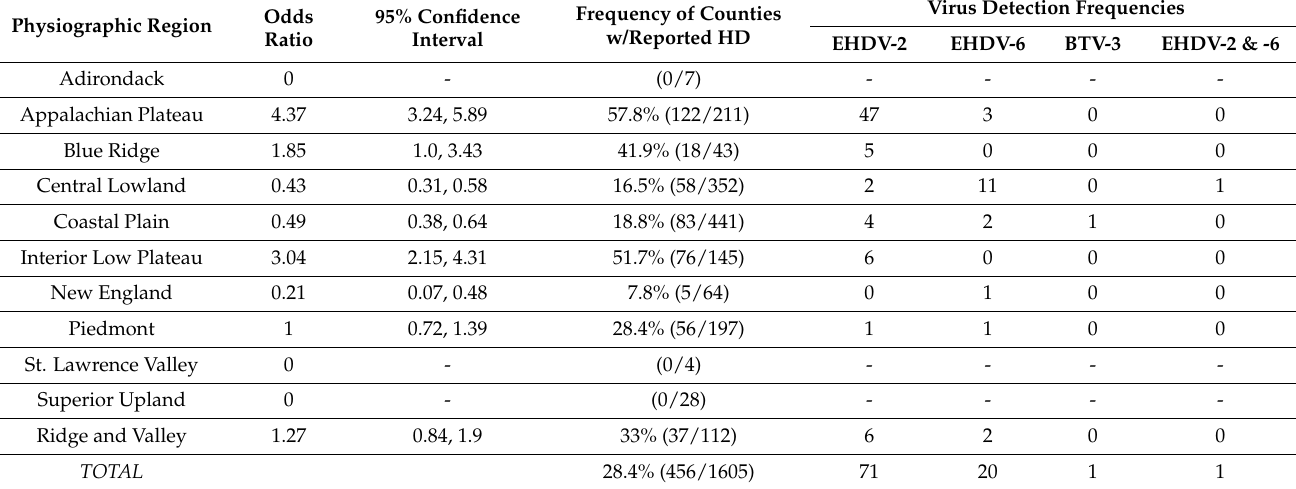
Figure 1. Map of hemorrhagic disease (HD) reports and virus isolation (epizootic hemorrhagic disease virus, EHDV, or bluetongue virus, BTV) results in 2017 by county in the eastern United States (left). Reports of HD that were not confirmed by virus isolation are green ( n = 362), red counties were EHDV-2 positive ( n = 71), blue counties were EHDV-6 positive ( n = 20). There was one county positive for BTV-3 (yellow) and one county that was positive for both EHDV-2 and EHDV-6 (purple). The map on the right was created and represents the major physiographic region by county in the eastern United States using USGS data [16]. Table 1. Odds ratios for reported and confirmed hemorrhagic disease (HD) in the eastern United States during 2017 based on physiographic regions. Epizootic hemorrhagic disease viruses and bluetongue viruses were identified on a subset of deer with suspected HD. There was a total of 456 counties that reported at least one or more cases of hemorrhagic disease. Physiographic Region